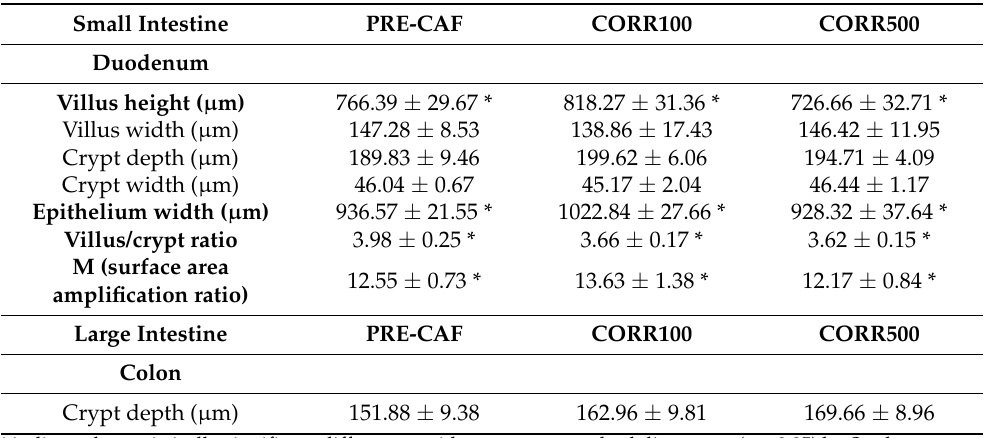
Table 5. Morphometric intestinal variables affected by cafeteria diet and GSPE treatments in Wistar rats. CORR100, corrective 10-day intervention at 100 mg/kg body weight; CORR500, corrective 10-day intervention at GSPE 500 mg/kg body weight. Values represent mean ± SEM; n = 10. In bold most relevant changes.